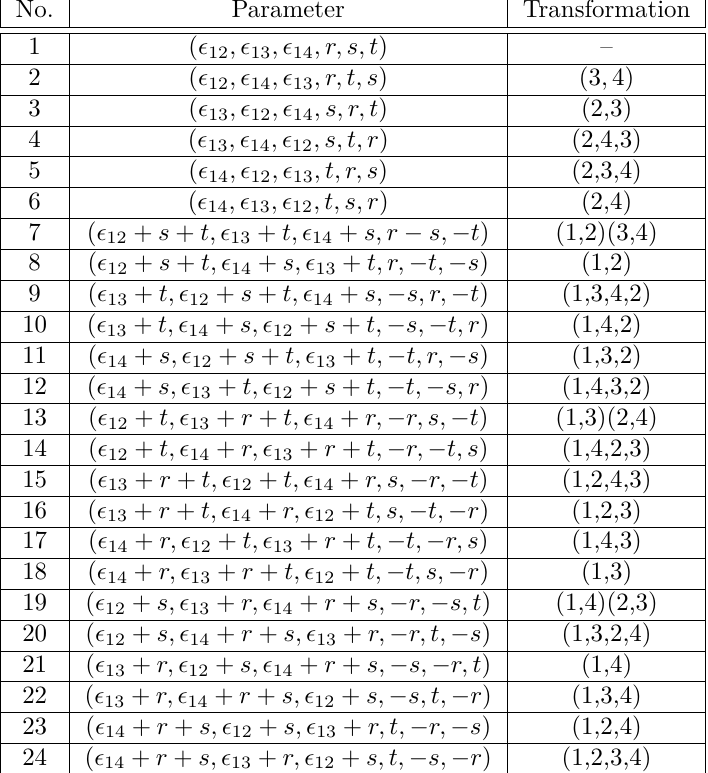
Table 4: A list of equivalent parameters, where the Transformation column corresponds to certain column and row permutations explained in the